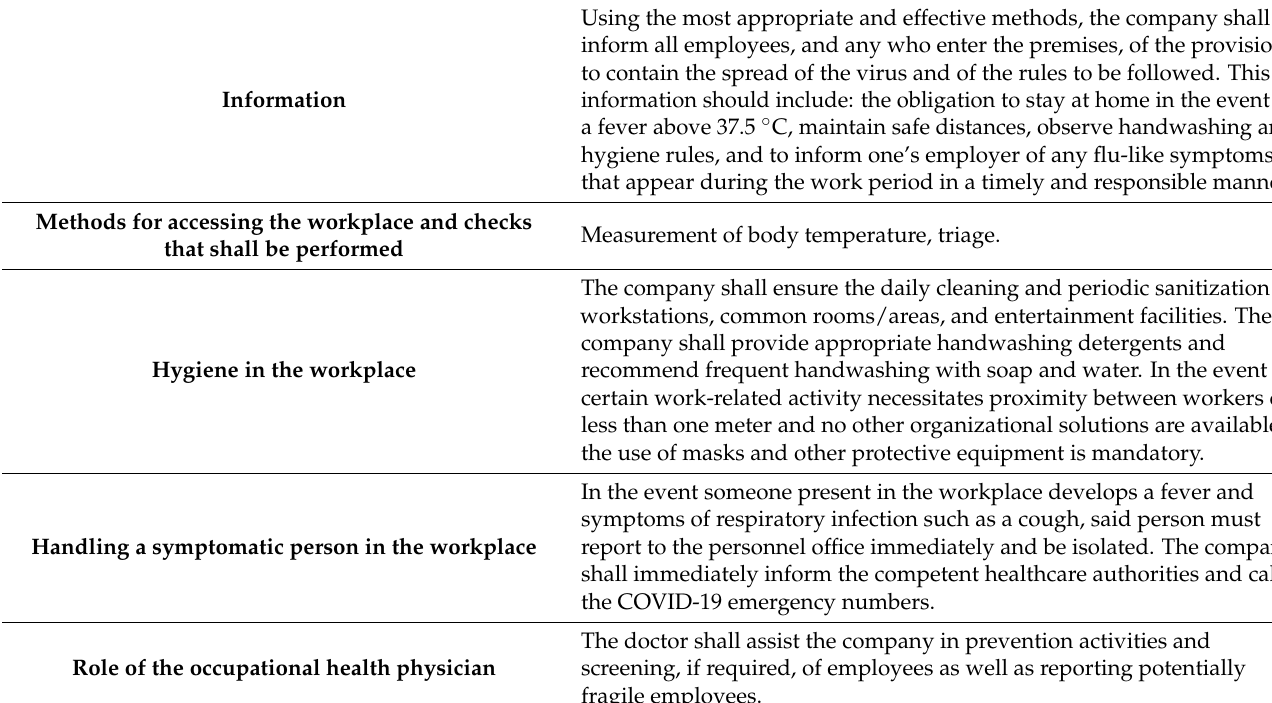
Table 1. Main recommendations listed in the agreement between the Italian government and representatives for companies and employees signed on the 24 March